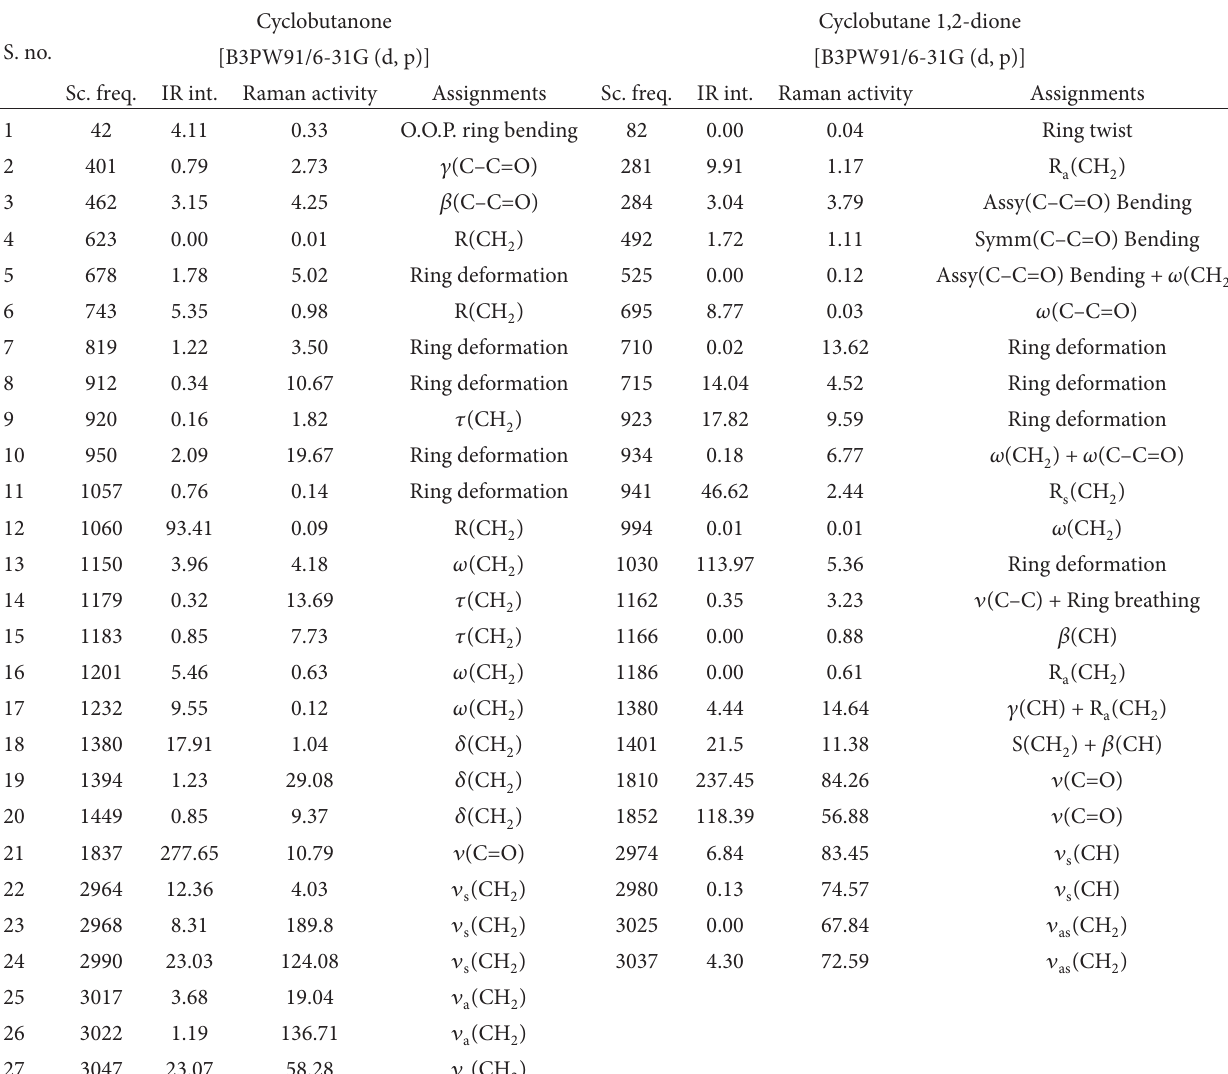
T 6: Comparative study of calculated wave numbers IR intensity and Raman intensity of 1,2-cyclobutanedione and